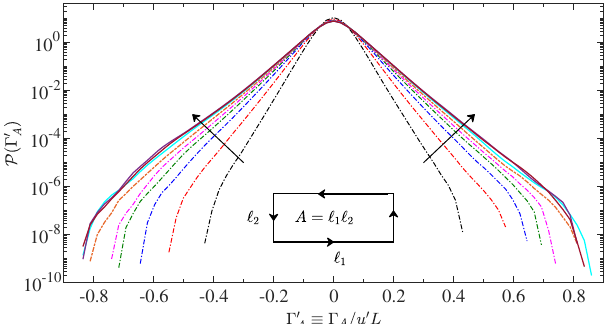
FIG. 2. Probability density function P of normalized circula- tion around loops with fixed area, A ¼ l 1 l 2 ¼ 4646 η 2 , but with different edge lengths, calculated for the 4096 3 data at R λ ¼ 650 . The dash-dotted lines correspond to contours with at least one side outside IR with the dimensions ð l 1 = η ; l 2 = η Þ as follows: (6.6,704), (11.0,422.4), (16.5,281.6), (22.0,211.2), (26.4,176.0), and (33.0,140.8), in the direction of the arrows shown. The collapsed solid lines correspond to loops with both sides ð l 1 = η ; l = η Þ contained within IR, and correspond to (44.0,105.6), 2 (52.8,88.0), and (66.0,70.4). The collapsed curves in IR verify the area rule to a good approximation, more broadly than Migdal ’ s anticipation for the tails (which drop off rapidly towards the extreme ends here because of finite sample sizes). The tails are approximately exponential in IR, especially for Γ A > 0 , but are fitted better by stretched exponential fits. The parameters of the stretched exponential vary only slightly from one loop to another in